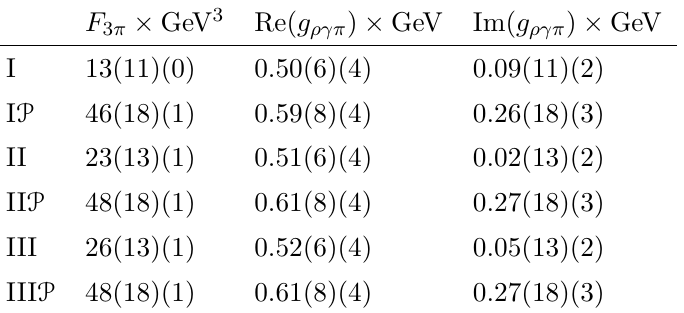
Table 4. The anomaly and the radiative coupling at the physical point. The fit uncertainty gives the first error, the second error corresponds to the error of the lattice